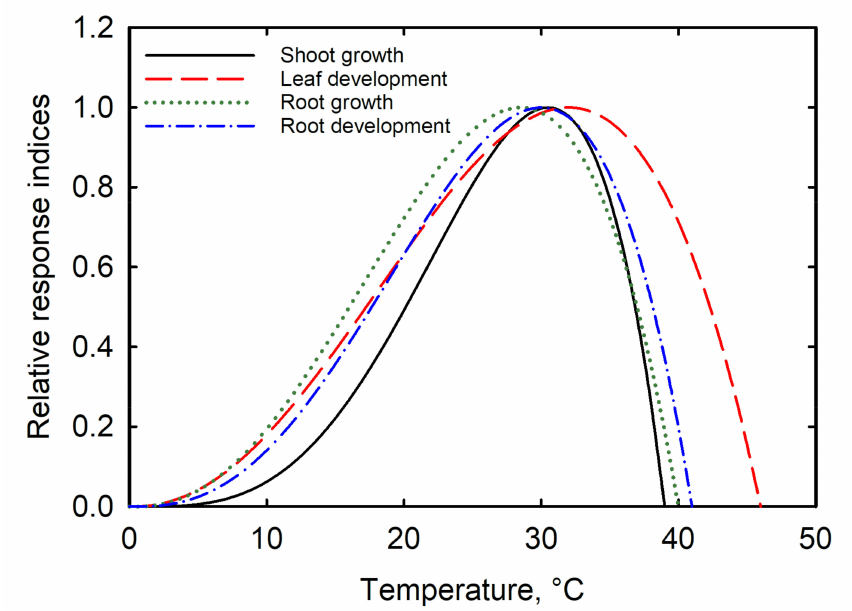
Figure 8. A simplified modified beta function best described the mean response of shoot growth, shoot development, root growth, and root development to